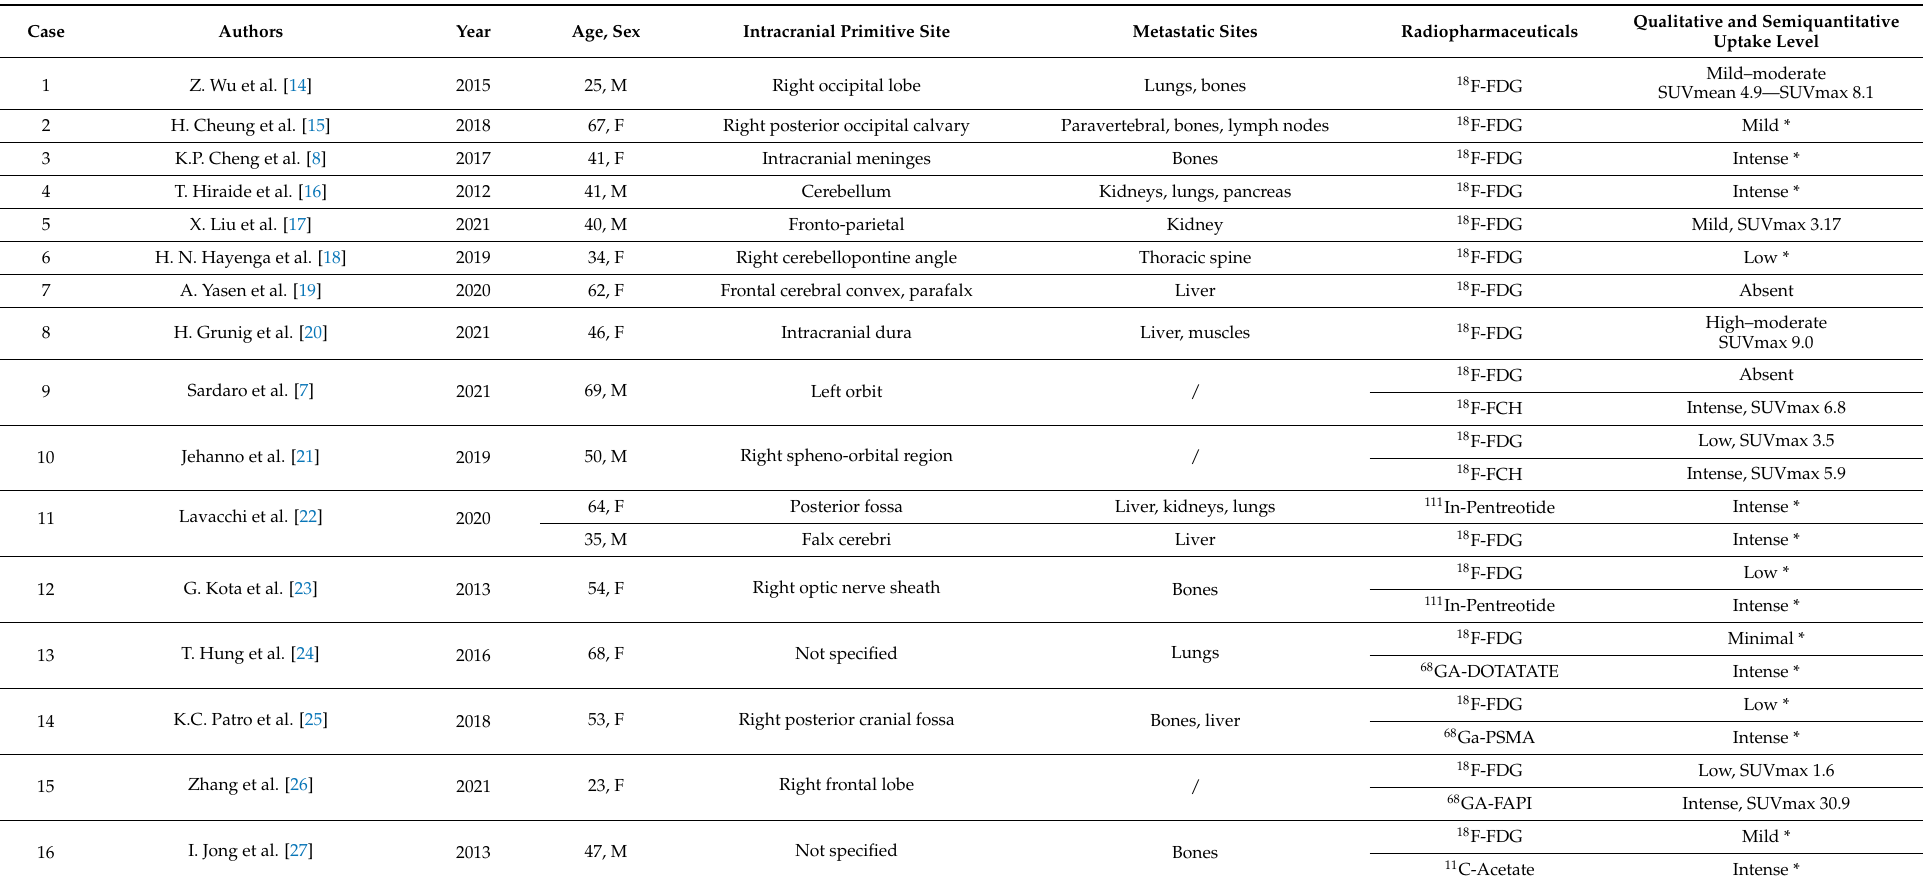
Table 1. Main characteristics of the included studies of intracranial SFTs/HPCs with probable distant metastases studied using PET/CT or scintigraphy with 111 In-Pentreotide ( n =